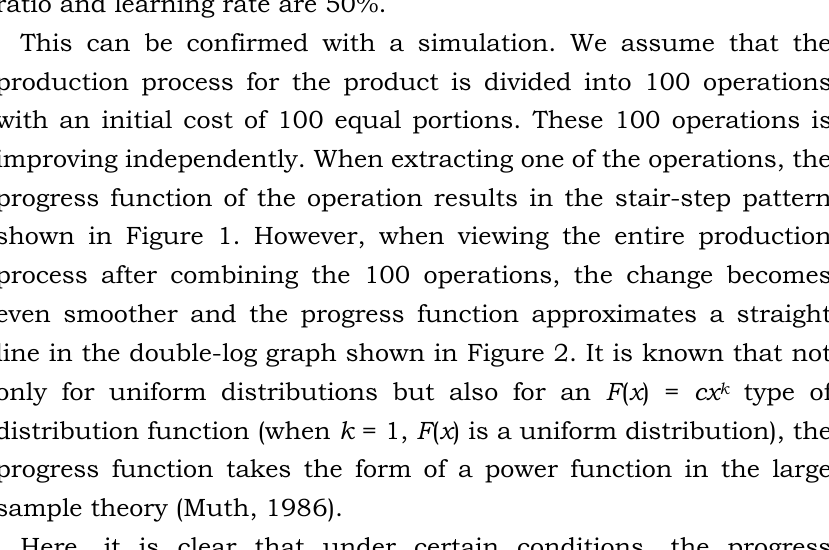
Figure 1. Basic model simulation at each operation level Source: Takahashi (2001), Figure